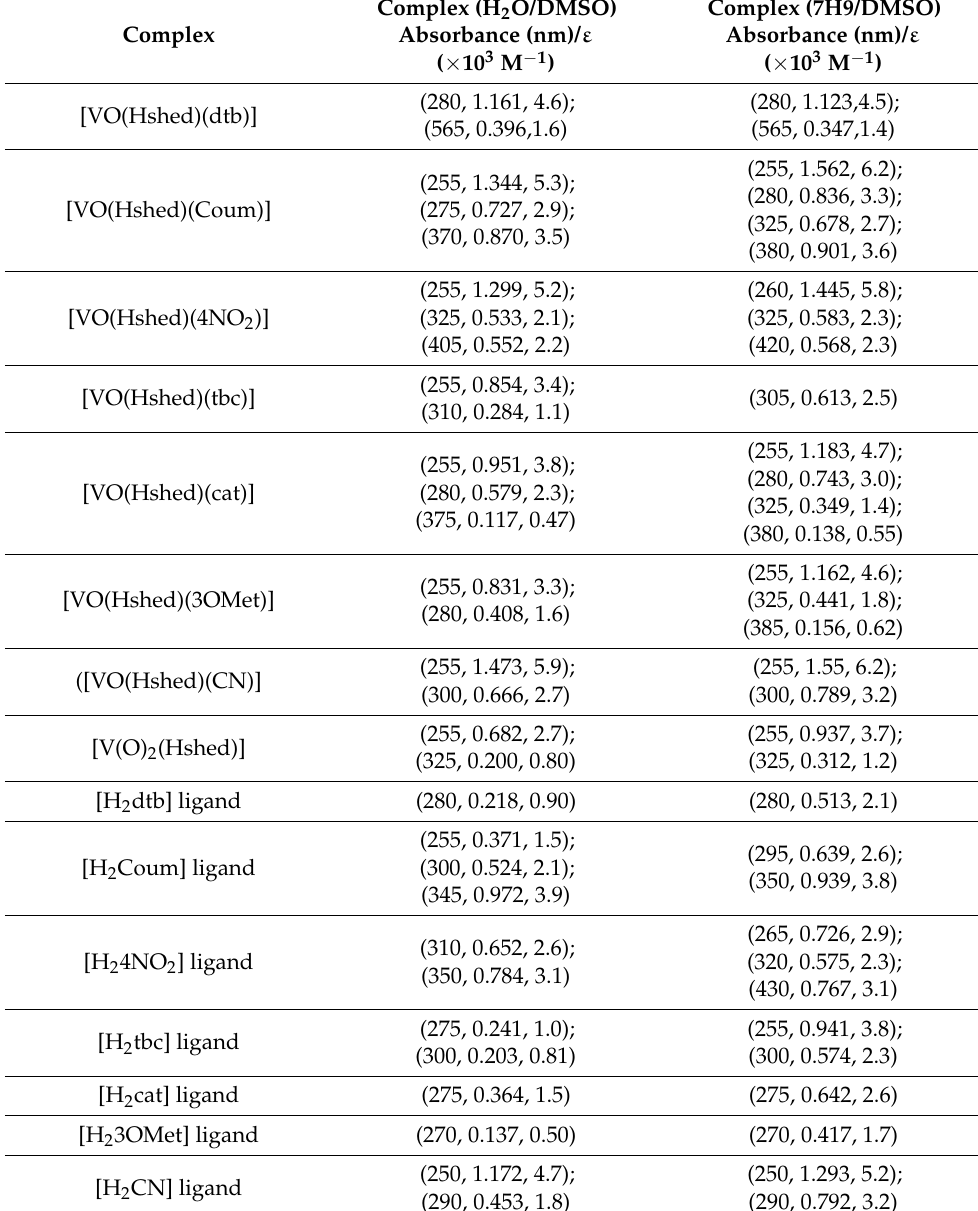
Table 3. UV-Vis parameters observed from the Schiff base V-catecholate complexes and free cat- echolate ligands at t = 0 h with 0.250 mM V-compound at 37 ◦ C a in the mixed solutions (94:6 H 2 O:DMSO or 94:6 7H9